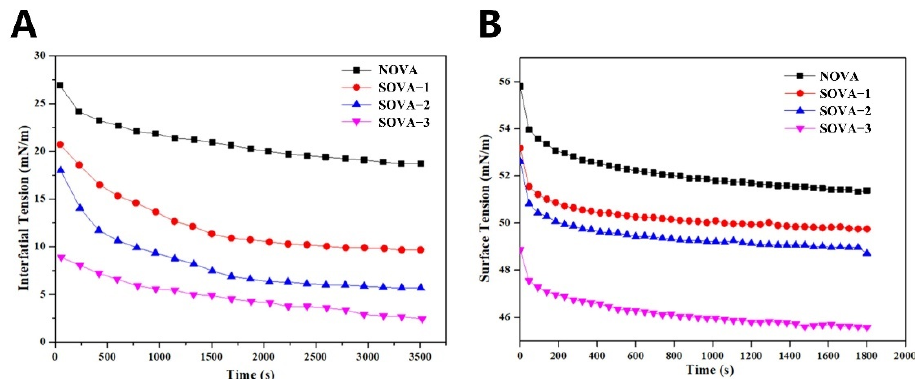
Figure 3. Interface tension between oil and protein solution ( A ), and surface tension between air and protein solution ( B ) of OVA with different succinylated degrees.